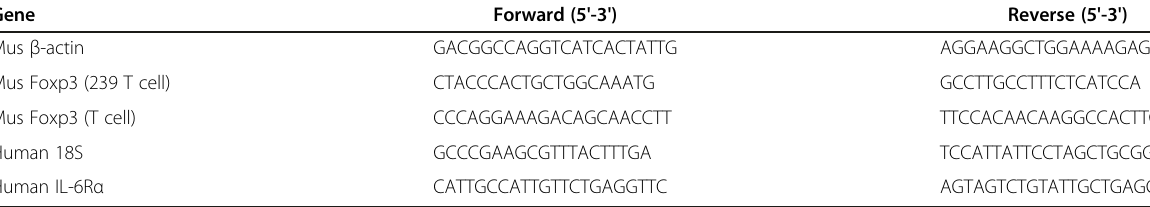
Table 1 The following primer pairs were used Gene Forward